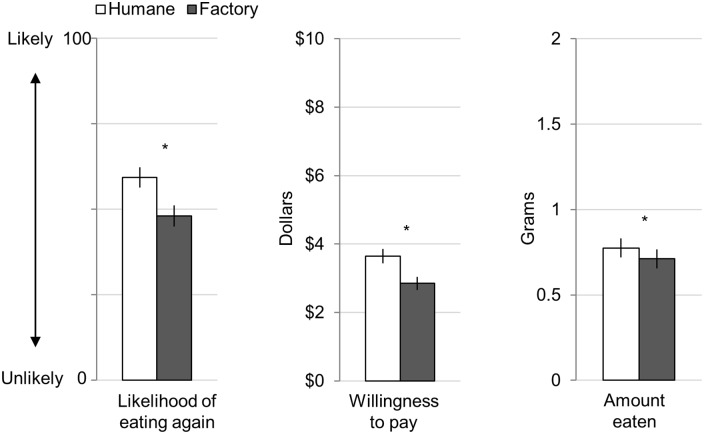
Study 1: Behavioral Measures for Beef Jerky Sample.Error bars represent standard errors, and asterisks represent significance (* p < 0.05).